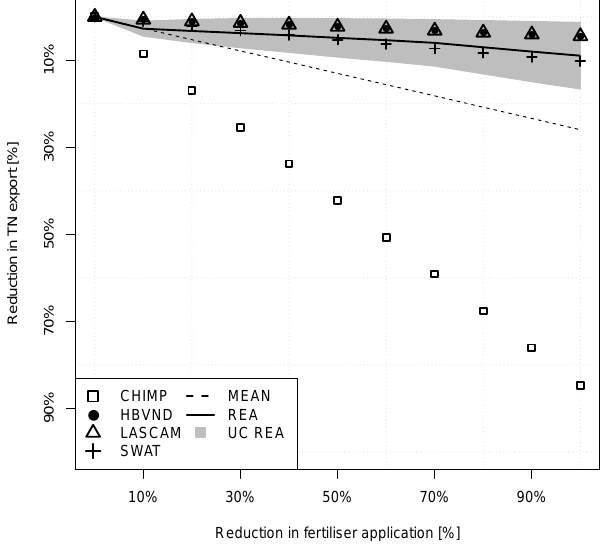
Fig. 4. Evolution of fractional TN export (a proportion of the initial TN export) with different scenarios of fertilisation